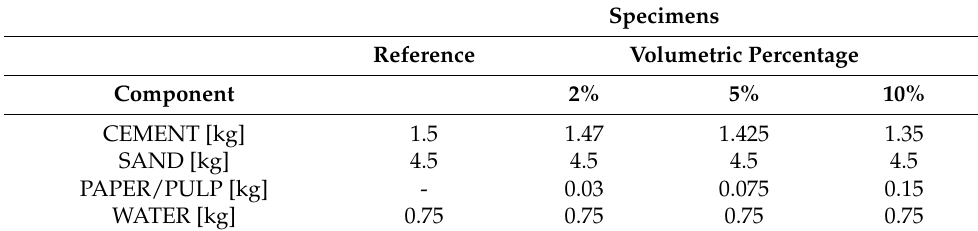
Table 1. Components proportioning for obtaining the specimens to be tested.